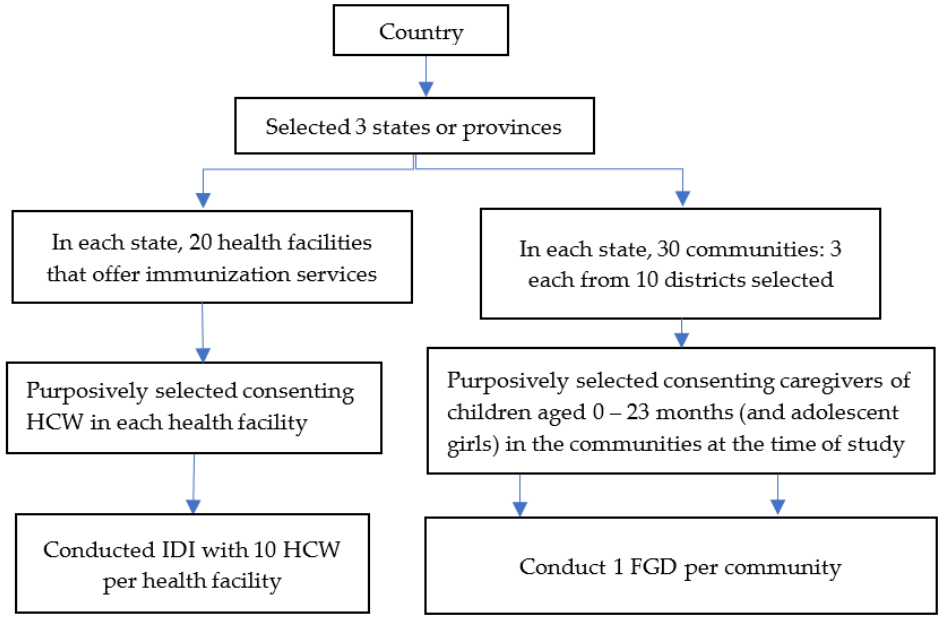
Figure 1. Study design flow.